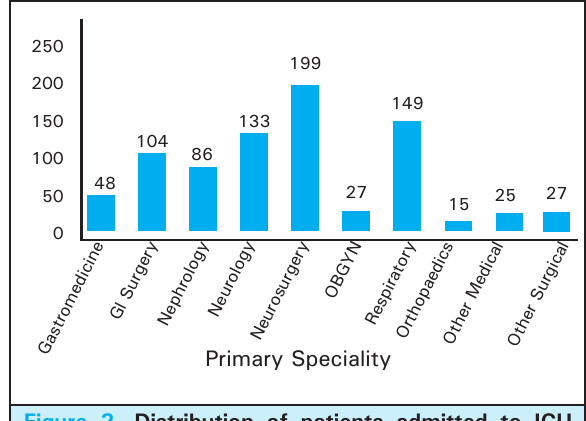
Figure 2. Distribution of patients admitted to ICU based on primary specialty.